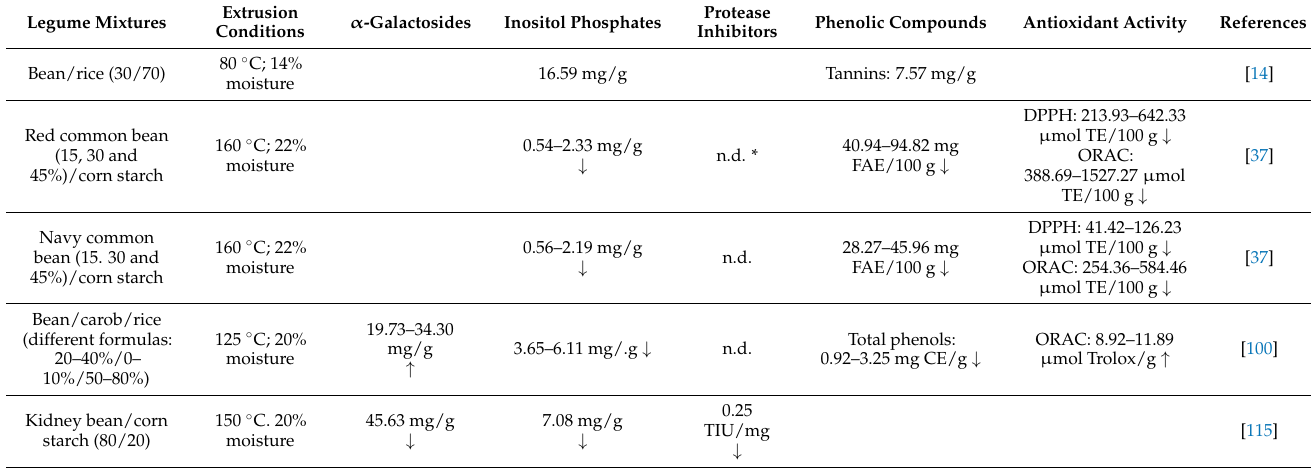
Table 3. Bioactive compounds ( α -galactosides, inositol phosphates, protease inhibitors, phenolic compounds and antioxi- dant activity) content in extruded legume mixtures with other